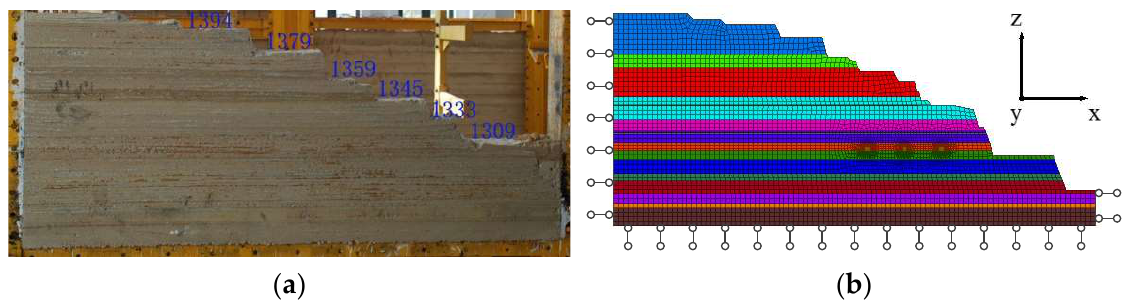
Figure 4. Physical and numerical models. ( a ) Physical model; ( b ) boundary conditions. Table 1. Physical and mechanical parameters of coal and rock.